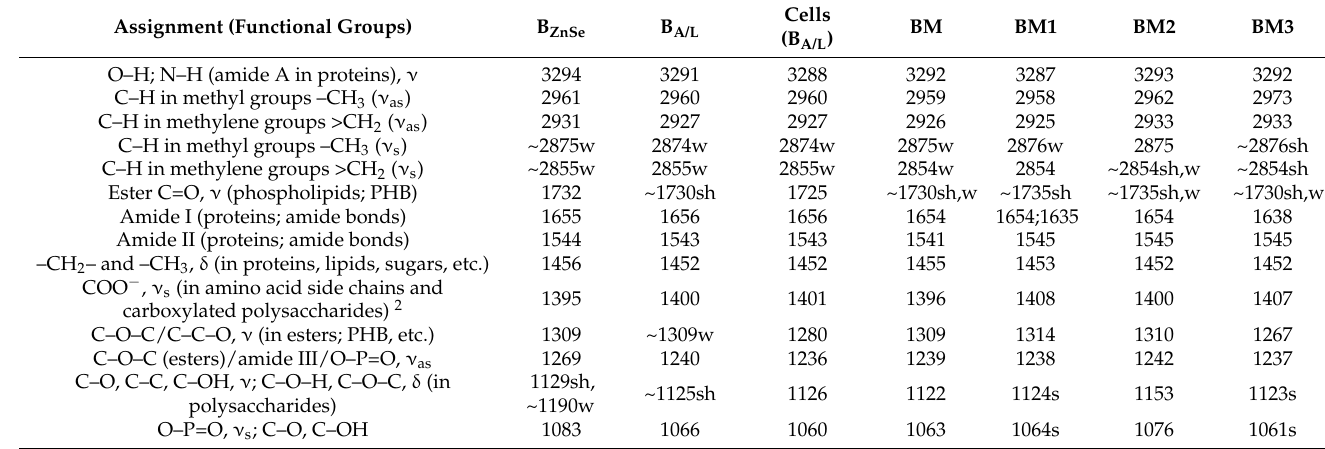
Table 2. Positions of the maxima of typical absorption bands (in cm − 1 ) in FTIR spectra of dried samples of biofilms formed by A. baldaniorum Sp245 at the ZnSe glass surface (B ZnSe ; see Figure 1A) or at the air–liquid interface (B A/L ; see Figure 2A) and its isolated cells (Cells(B A/L ); see Figure 2B), biofilm matrix (BM; see Figure 2C) and its fractions: BM1 (see Figure 3A), BM2 (see Figure 3B)